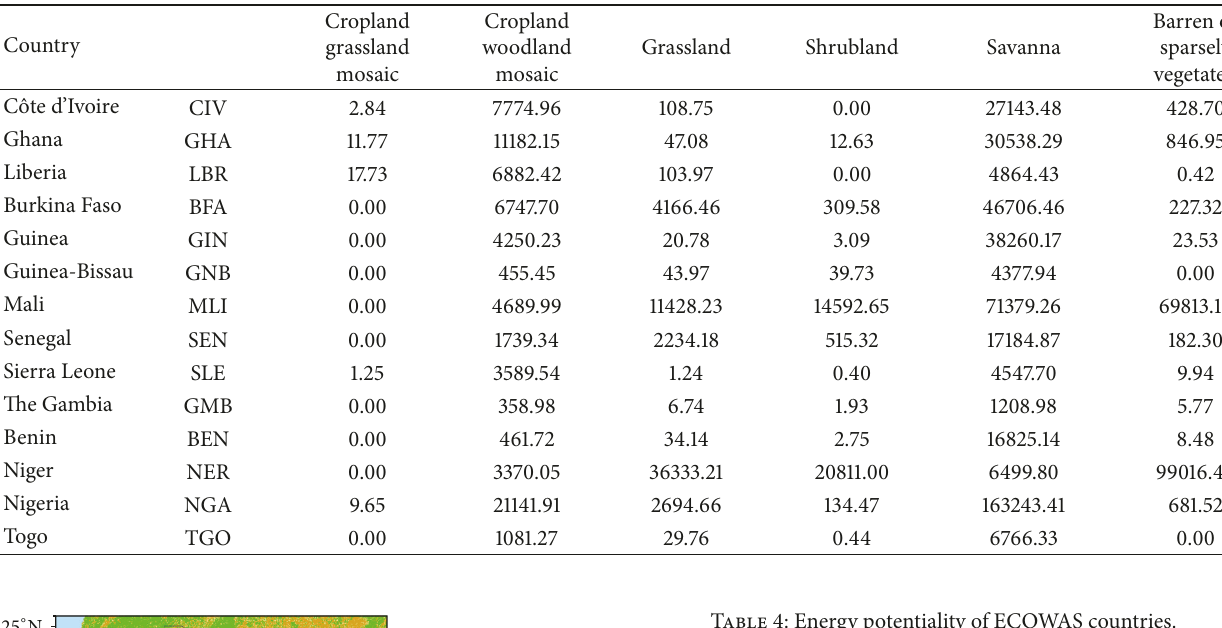
Table 3: Energy potentiality (TWh ⋅ year −1 ) of ECOWAS countries by suitable land type.